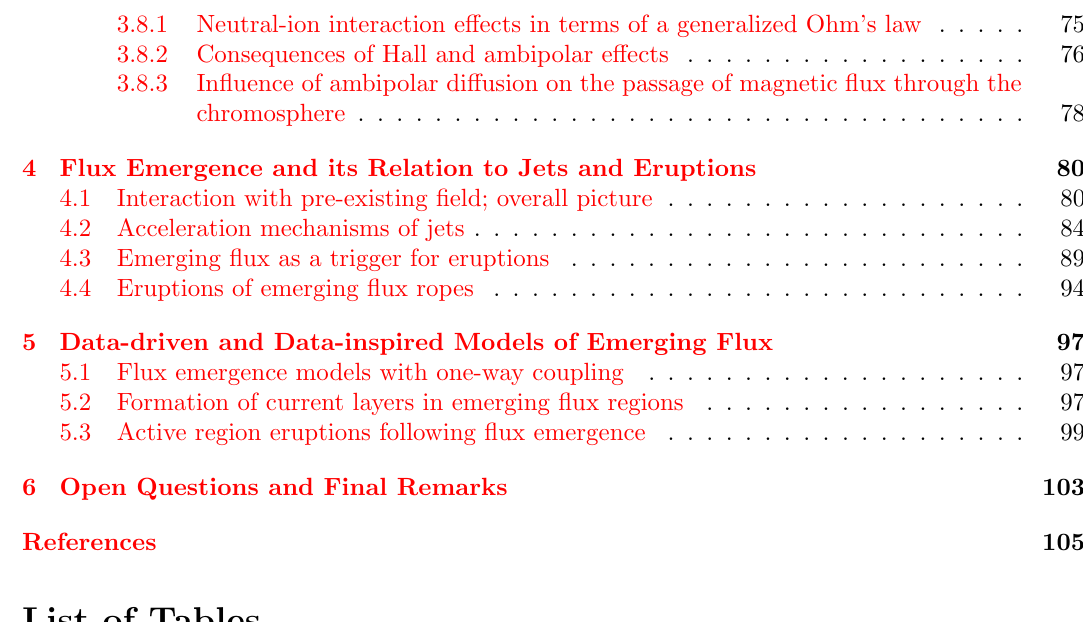
Summary of the impact of various effects present in MHD of partially ionized plasmas.